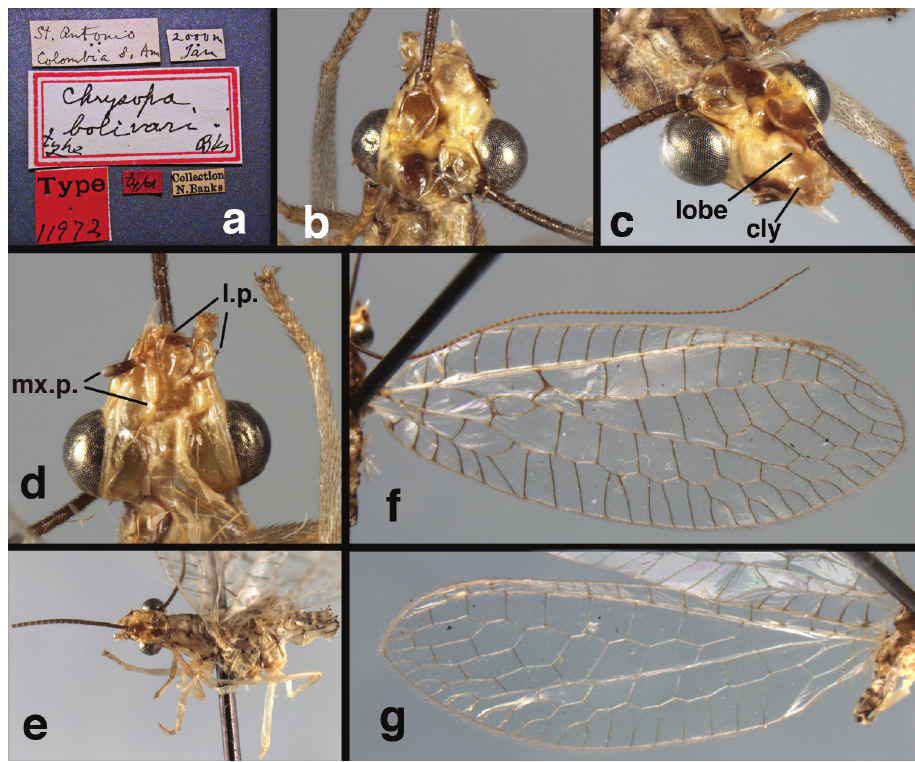
Figure 17. Chrysopa bolivari Banks: External features, ( a ) labels ( b ) head, dorsum, damaged ( c ) head, fron- tolateral, damaged [note: protruding mesal lobe beneath scape and bulbous clypeal area] ( d ) head, ventral ( e ) body, lateral ( f ) forewing ( g ) hindwing. cly clypeus l.p. labial palp mx.p. maxillary palp lobe protruding frontal lobe (all: Colombia, San Antonio, holotype, probably male, terminalia missing,